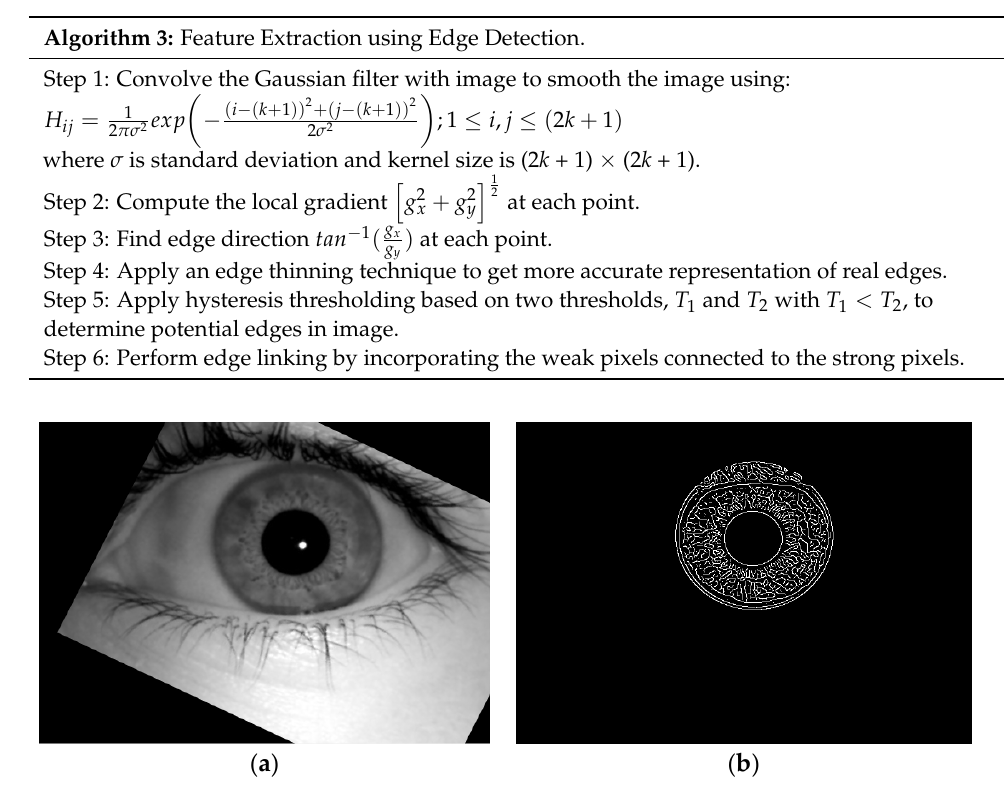
Figure 8. Feature extraction using canny edge detector. ( a ) Original eye image. ( b ) Output image of feature extraction using edge detection.